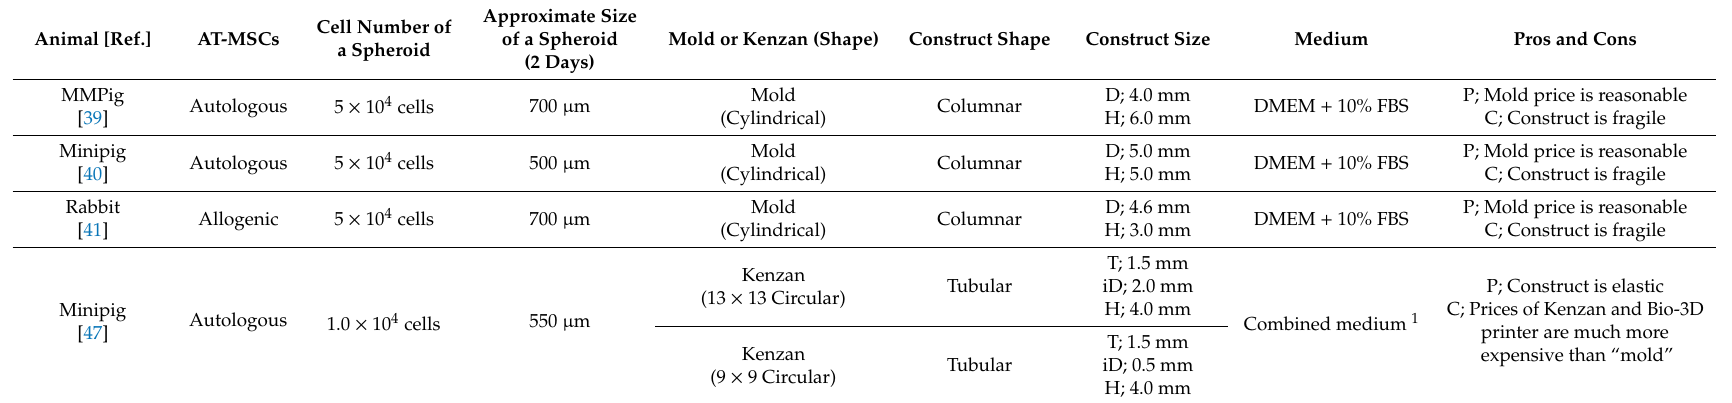
Table 3. Fabrication conditions for the bio-3D